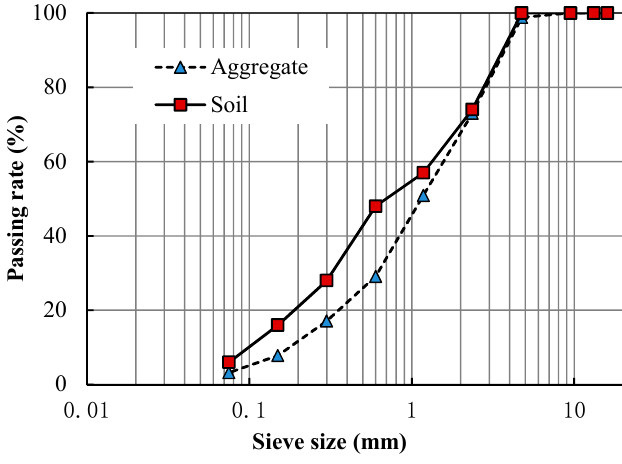
Table 4. Physical properties of the soil.